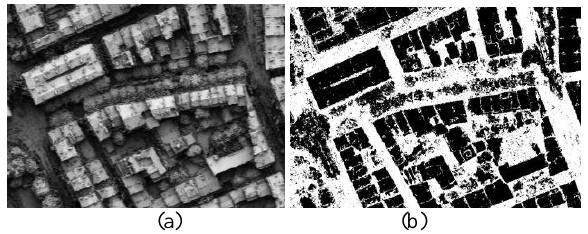
Figure 1: Original DSM (a) and unreliable areas in white (b).